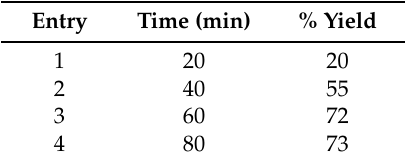
Table 5. Milling of 2.5 g of o -phenylenediamine and 1.5 g of urea with 56.6 g of balls at 20 Hz.